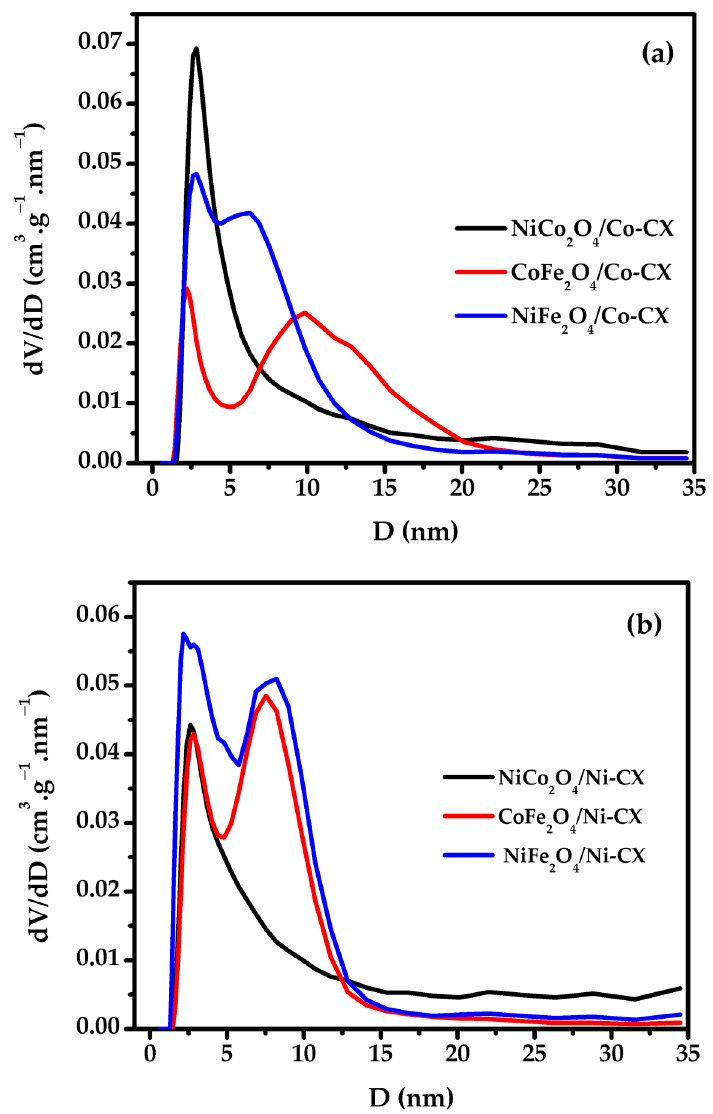
Figure 1. DFT analysis for adsorption part of N 2 -adsorption / desorption isotherms, ( a ) bimetal oxides doped cobalt xerogels, ( b ) bimetal oxides doped nickel xerogels.